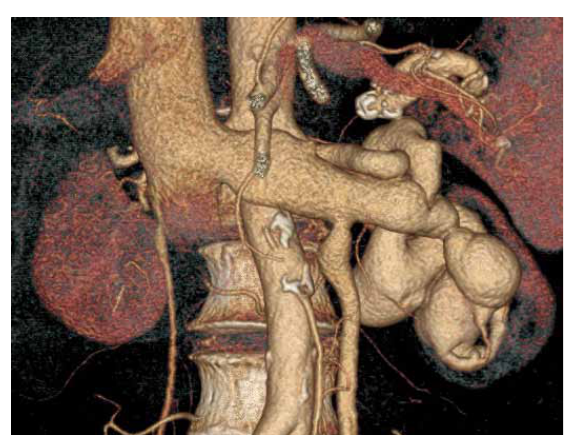
Figure 3. Multi Slice Computed Tomography revealed giant AVF of the left kidney with severe dilatation of all interlobar veins, renal, ovarian and adrenal vein.